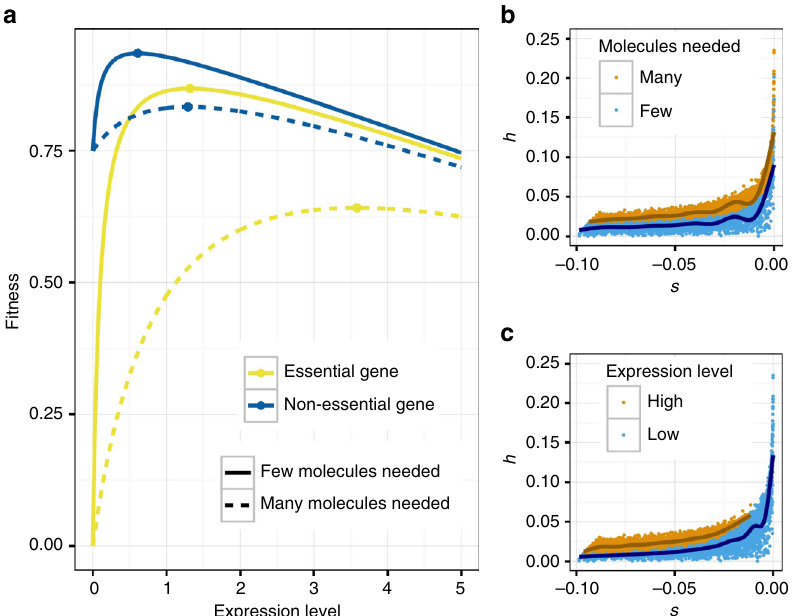
Fig. 5 A new, comprehensive model for the evolution of dominance. a The relationship between fi tness and expression level (arbitrary units). A fi tness cost for increasing gene expression is assumed (see the main text). b Predicted h – s relationship when many molecules (orange) and few molecules (blue) are needed. c Predicted h – s relationship when the expression level is high (orange) and low (blue). Note that the patterns predicted in b , c mirror those